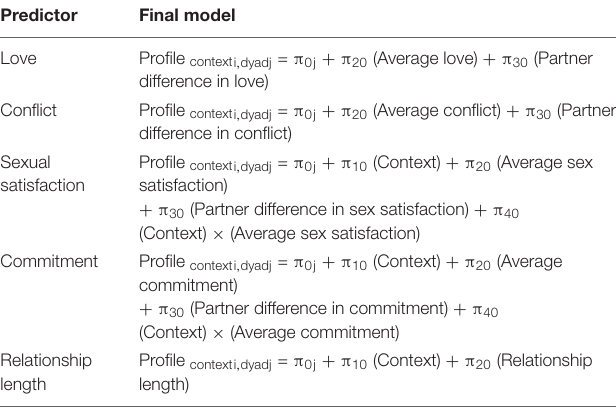
TABLE 4 | Specification of fixed effects for final models for each predictor variable. All models included a random couple intercept to account for nesting of contexts in